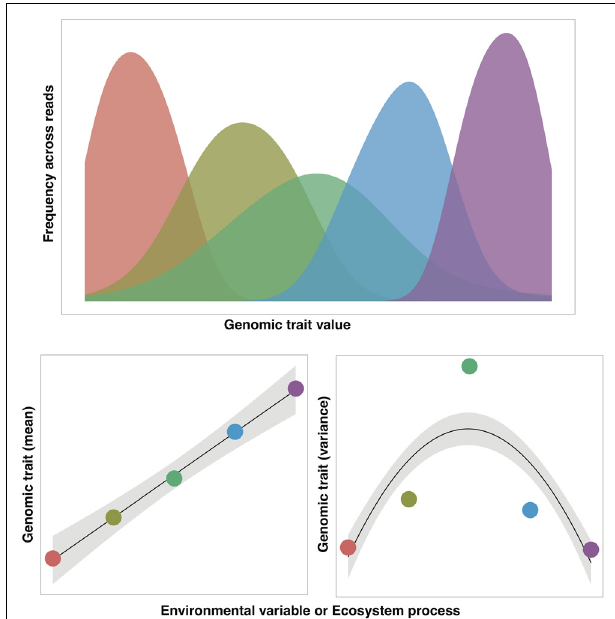
FIGURE 1 | Conceptual distribution of a community-aggregated trait (CAT) as inferred from the frequency of sequence reads from five different metagenomes (represented as different colors). For an illustrative purpose, we can assume that the mean value of the trait increases along an environmental gradient or correlates with an ecosystem process of interest. Likewise, we can assume that the variance of this same trait is reduced at the extreme values of the gradient/process as a result of selective pressures.Trait distributions as conceptualized in this figure have been observed, for example, in the distribution of GC content across aquatic metagenomes (Barberan etal.,